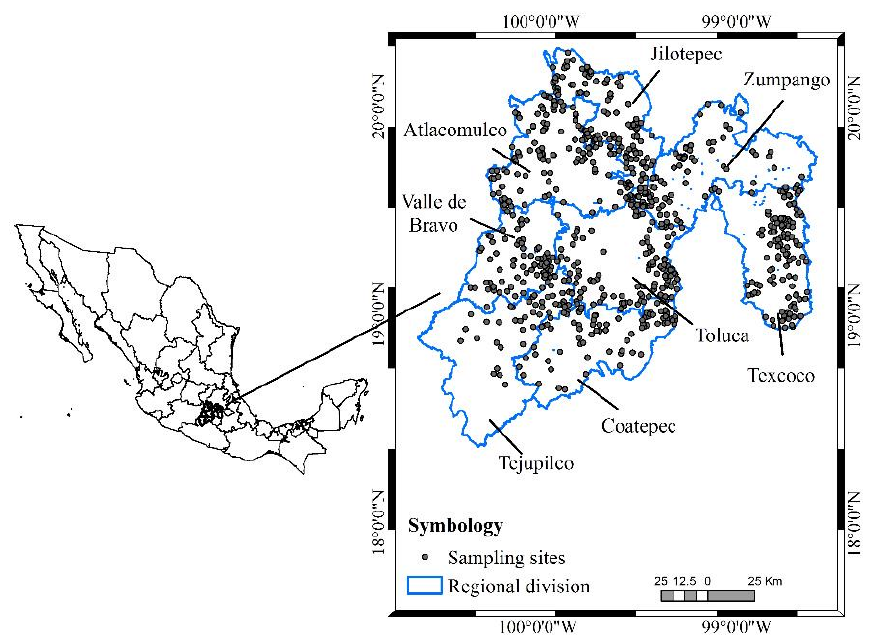
Figure 1. Spatial location of the sampling sites, within the forest regions of the State of Mexico.